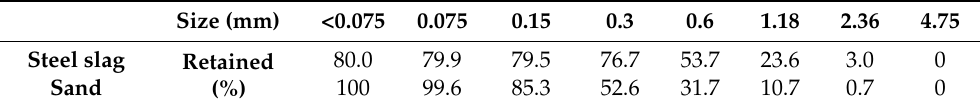
Table 3. Particle size distribution of fine aggregates.